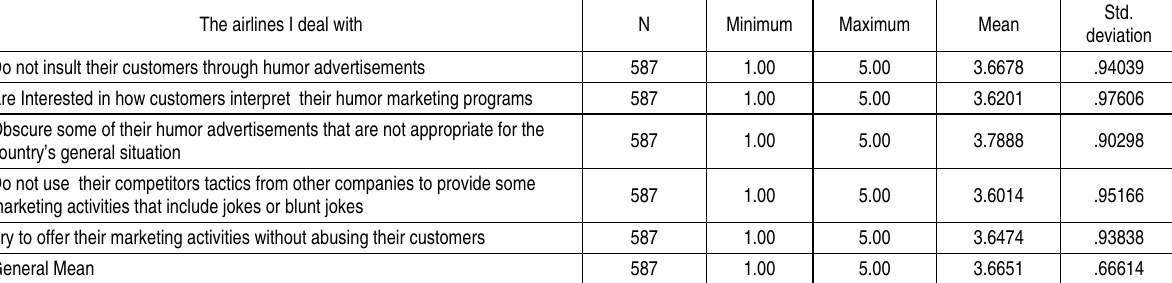
Table 8. Means and standard deviations of sample’s responses regarding the aggressive humor